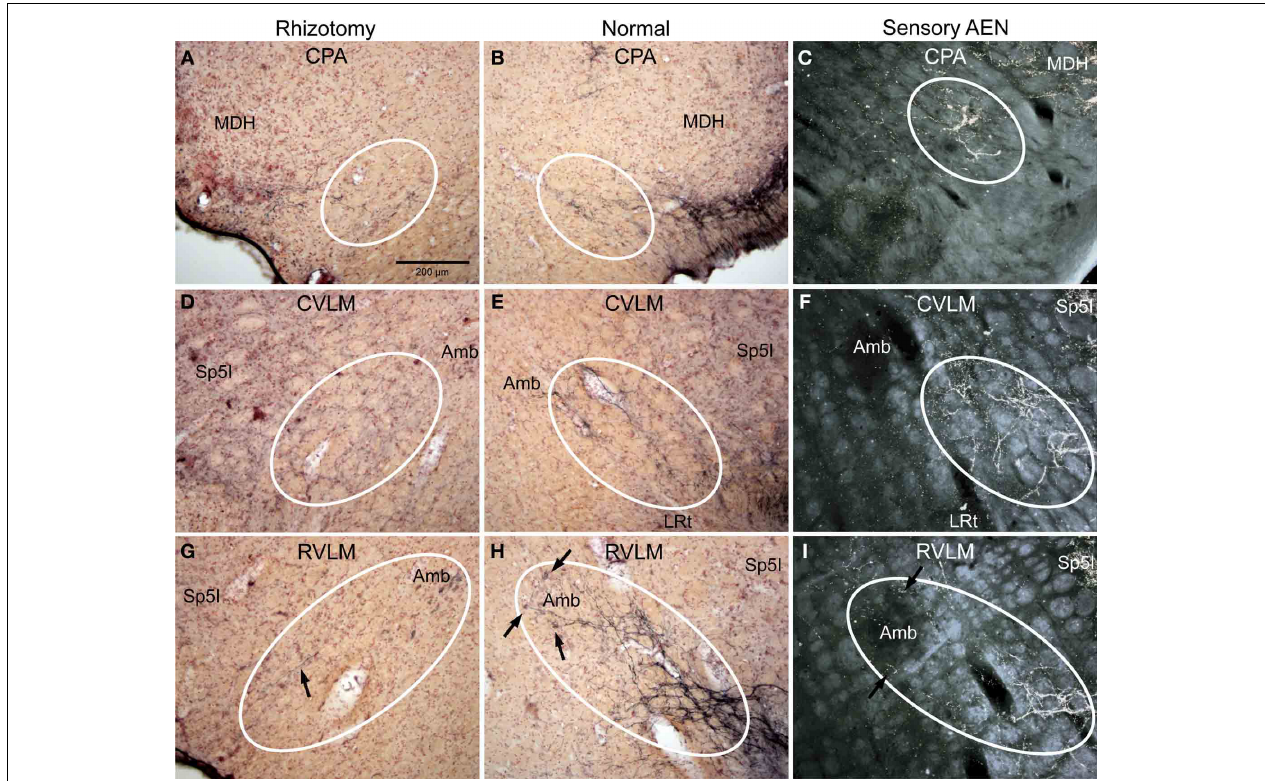
FIGURE 3 | Photomicrographs of sections illustrating loss of CGRP immunoreactivity in reticular areas after unilateral trigeminal rhizotomy. Compare the distribution of CGRP fibers on the non-experimental side ( B , E , H ; Normal) to fibers of the anterior ethmoidal nerve, a branch of the ophthalmic division of the trigeminal, labeled after transganglionic transport ( C , F , I ; Sensory AEN). Note the striking similarity of these two distributions. The moderate amount of CGRP-labeled fibers in the CPA ( B , outlined) was reduced but not eliminated after trigeminal rhizotomy (A) . However, that to